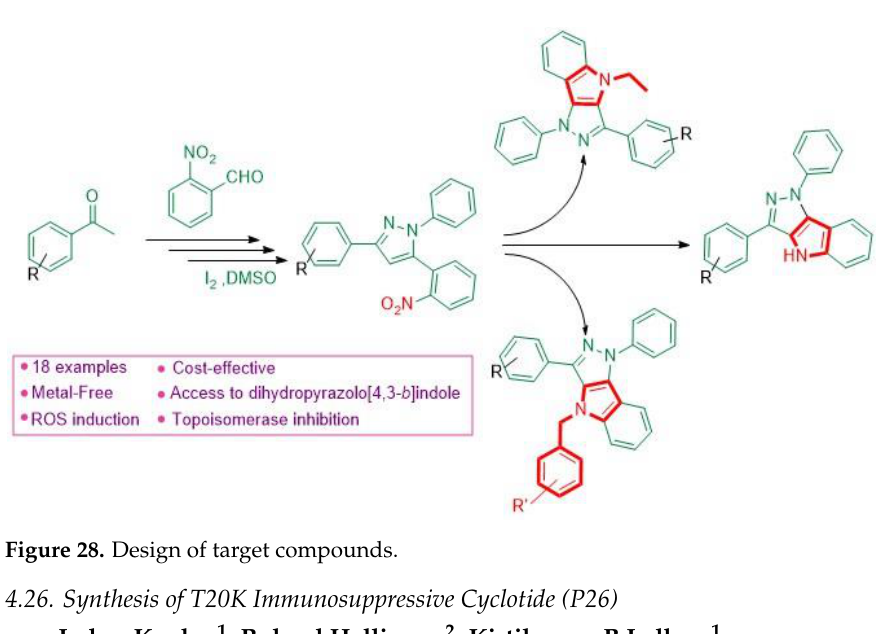
Figure 28. Design of target compounds.